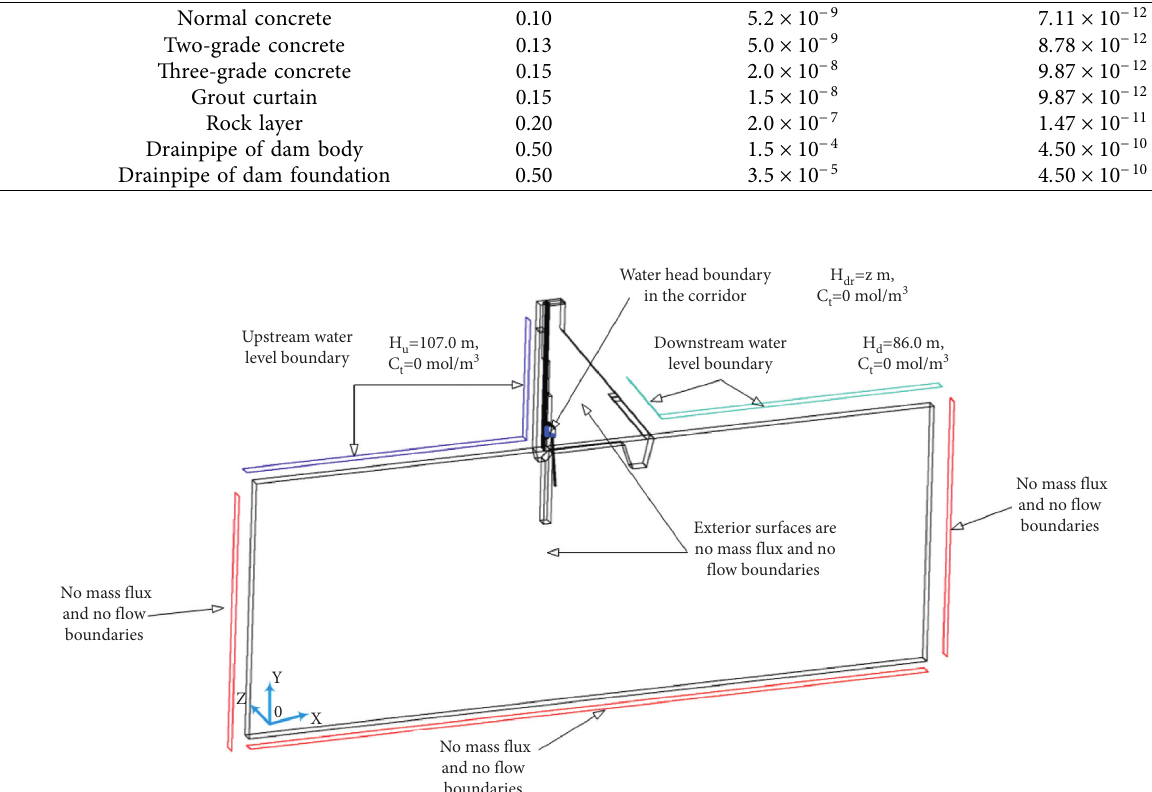
Figure 12: The initial and boundary conditions of the Shimantan